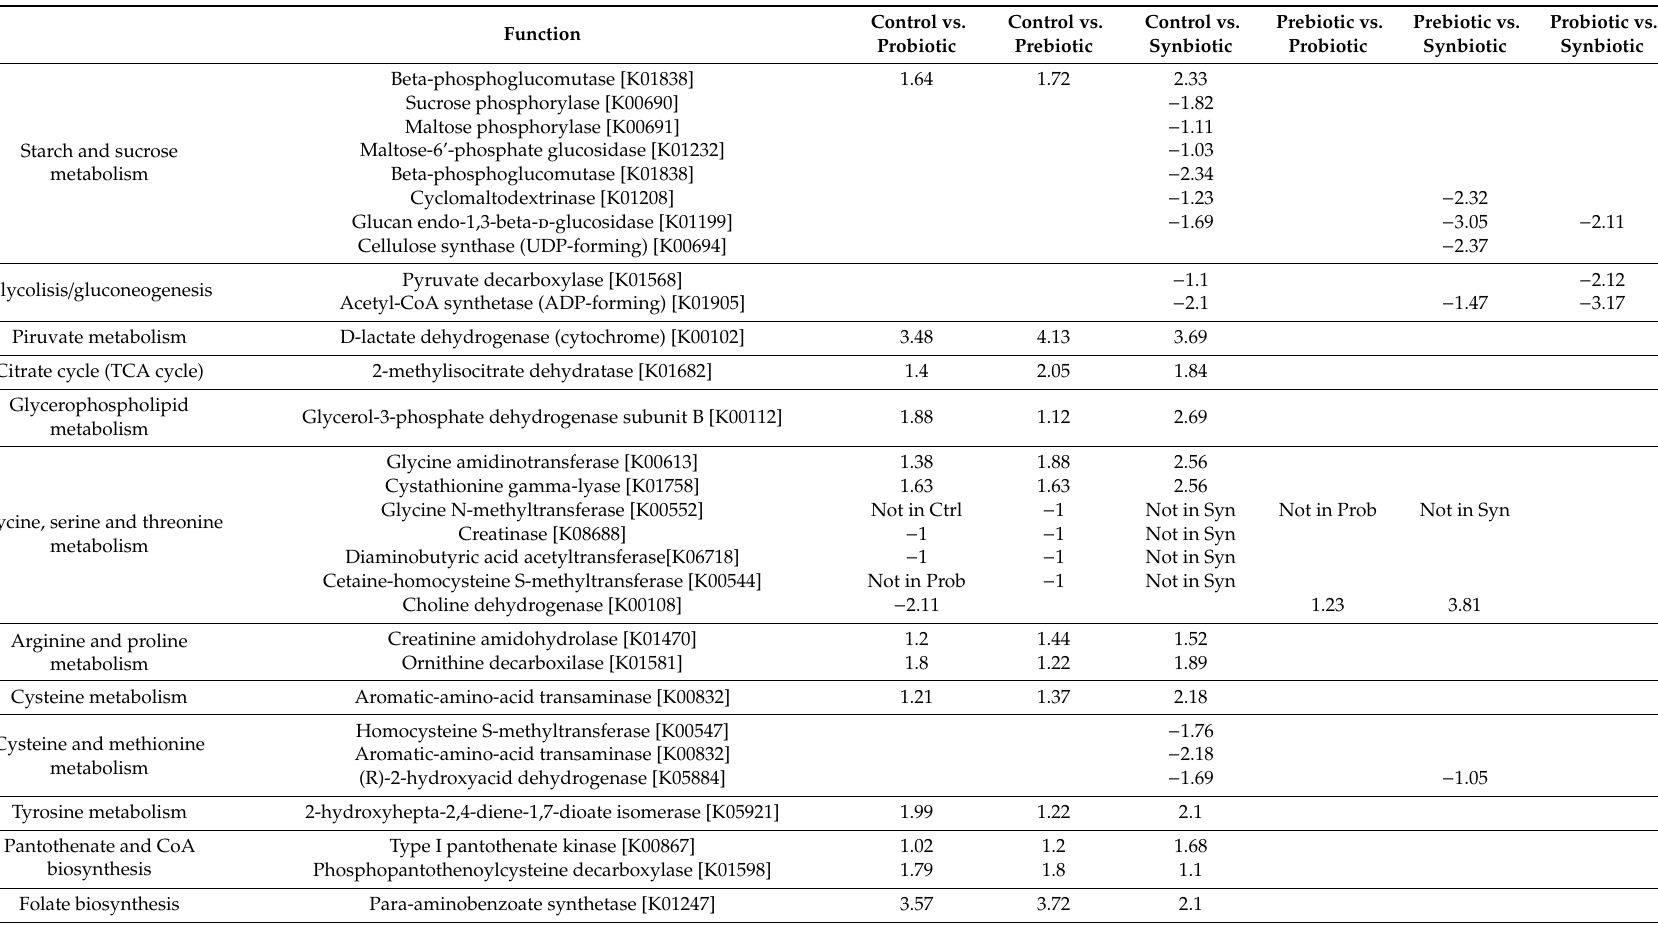
Table 2. Genes di ff erentially present based on the dietary treatment assigned. The di ff erence was calculated with the log2fold change (LFC), after read normalization, using DESeq2 R package (Love et al., 2014) [33]. A cut-o ff criterion was established, which was p < 0.05 (Wald test). Positive or negative values indicate a higher or lower presence, respectively, of the assigned function, for the first mention